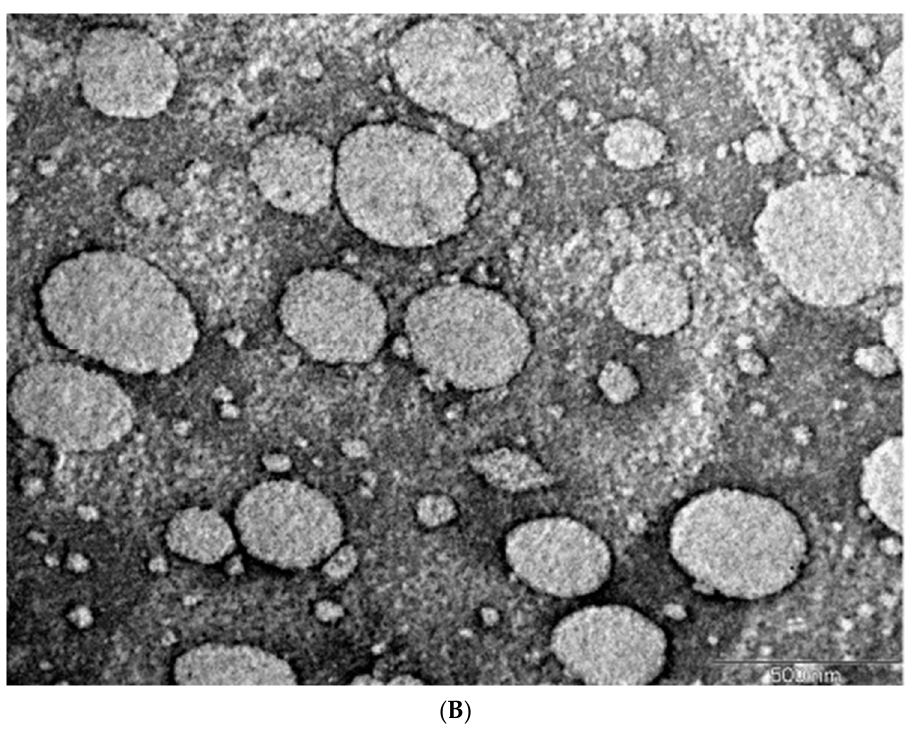
Figure 3. Morphology of CKR12-PLGA-MCZ micelles determined by transmission electron mi- croscopy ( A ) and transmission electron microscopy image of CKR12-PLGA micelles ( B